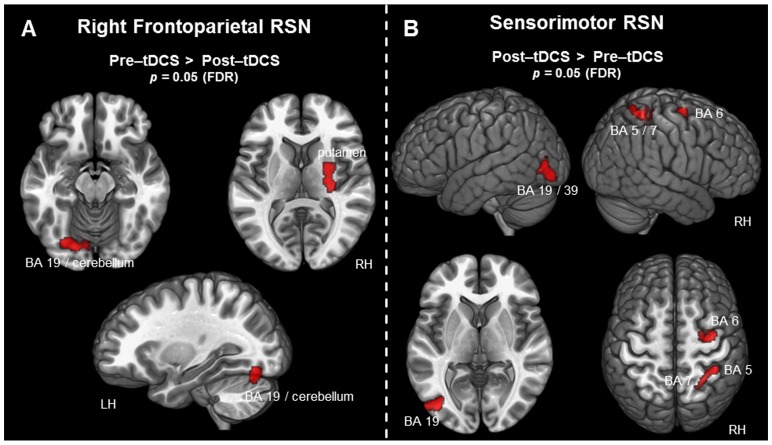
Voxel-wise difference maps for the right frontoparietal and the sensorimotor RSN.Activity detected in the context of the right frontoparietal and the sensorimotor RSN is displayed at a cluster-level threshold of p<0.05 (FDR corrected) and projected on the MNI template brain (ICBM 152). A) Areas associated with the right frontoparietal RSN exhibiting decreased activity following tDCS. B) All areas associated with the sensorimotor RSN exhibiting increased activity following tDCS. (BA =  Brodmann area; FDR =  false discovery rate; LH =  left hemisphere; RH =  right hemisphere; RSN =  resting-state network).